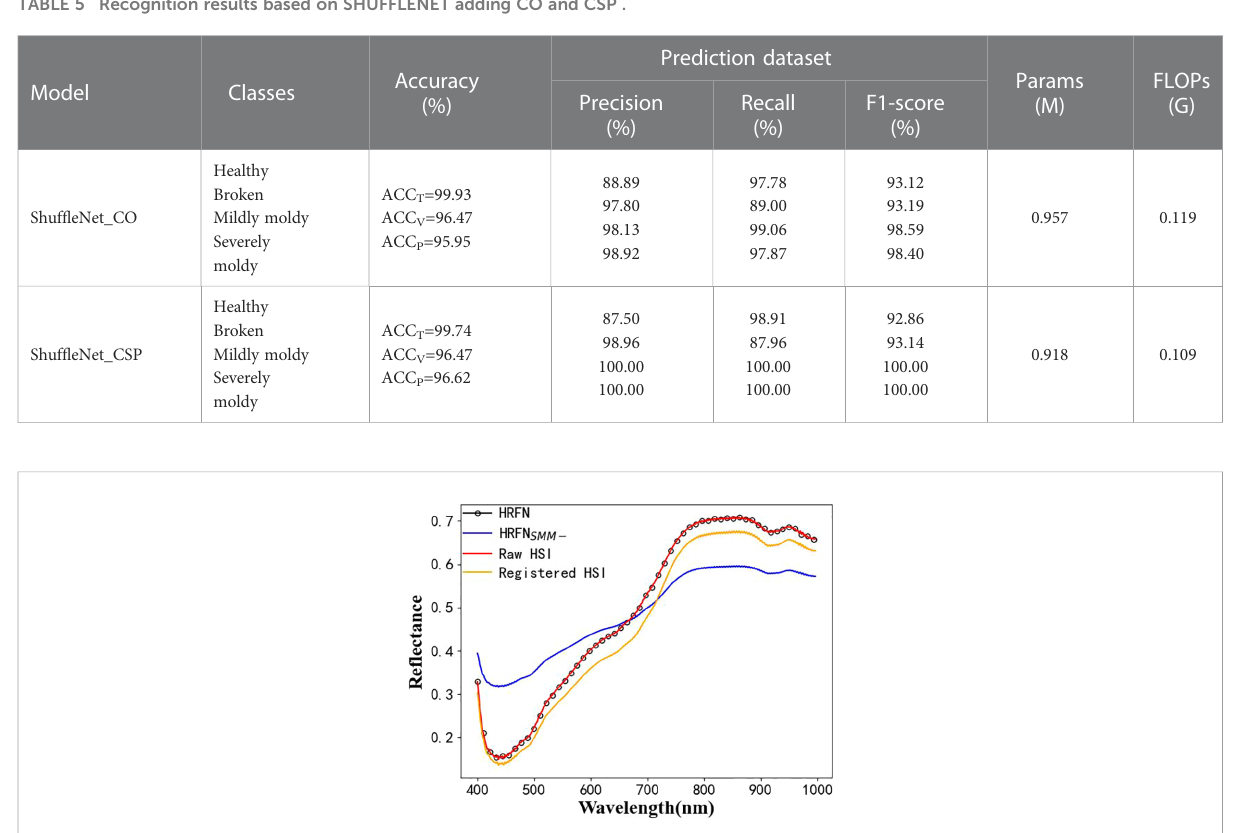
FIGURE 7 Spectral re fl ectance for the broken class of soybean as obtainedby the raw HSI, registered HSI, and the fused results of HRFN and HRFN SMM-